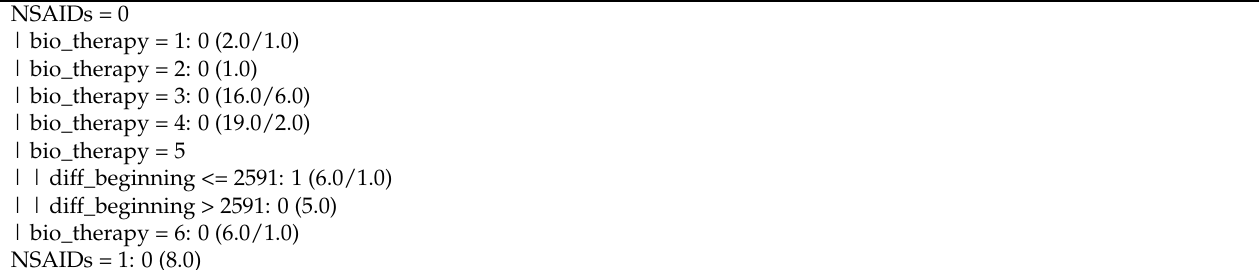
Table 19. Decision tree for QuantiFERON prediction, obtained with the unpruned C4.5 algorithm on the training